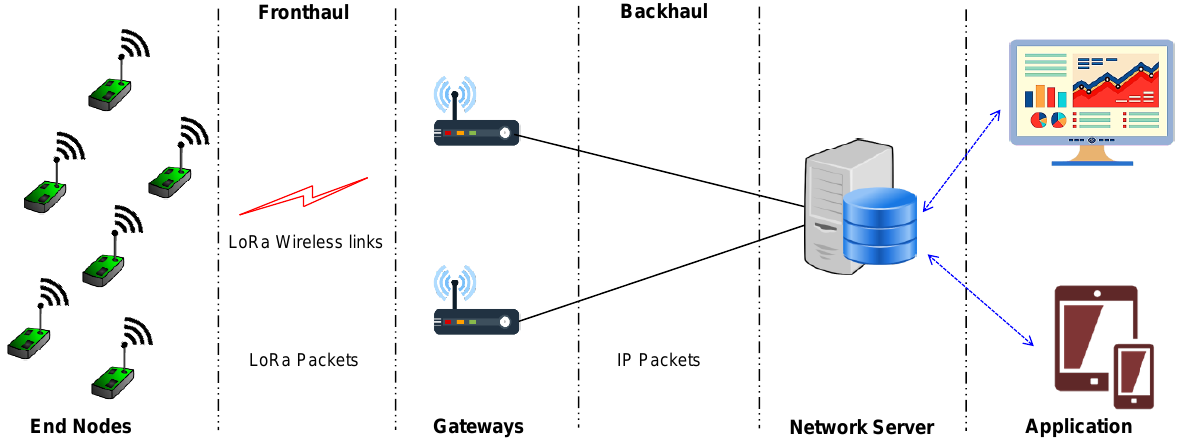
Figure 13. LoRa network architecture. Table 10. Comparison of key parameters of Sigfox, NB-IoT, and LoRa technologies.